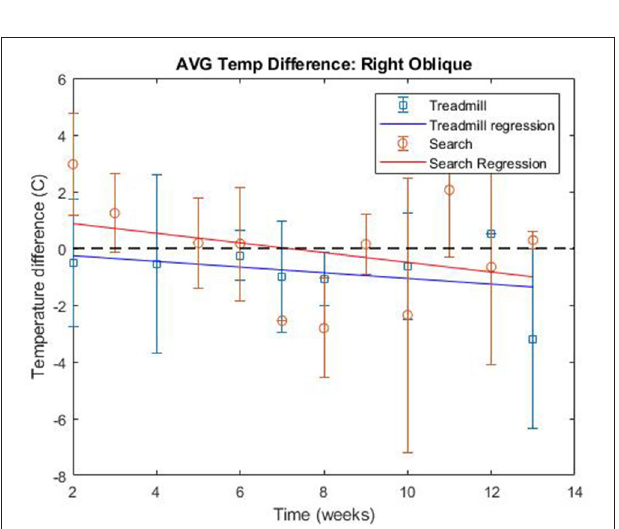
FIGURE 12 | Average thermographic intensity difference over study time for right oblique region.